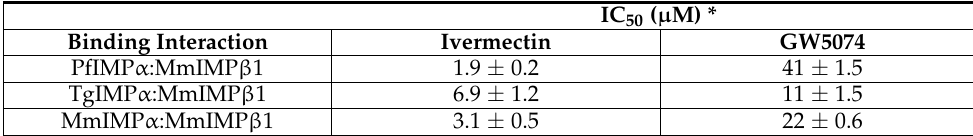
Figure 4. Ivermectin and GW5074 inhibit IMP α –IMP β interaction. AlphaScreen technology was used to determine the IC 50 for inhibition by ivermectin and GW5074-binding of IMP β (30 nM) to IMP α s (30 nM). Data represent the mean ± SEM for quadruplet wells from a single experiment, from a series of three independent experiments (see Table 4 for pooled data). Table 4. Summary of data analysis for inhibition binding of IMP α to IMP β 1 by ivermectin and